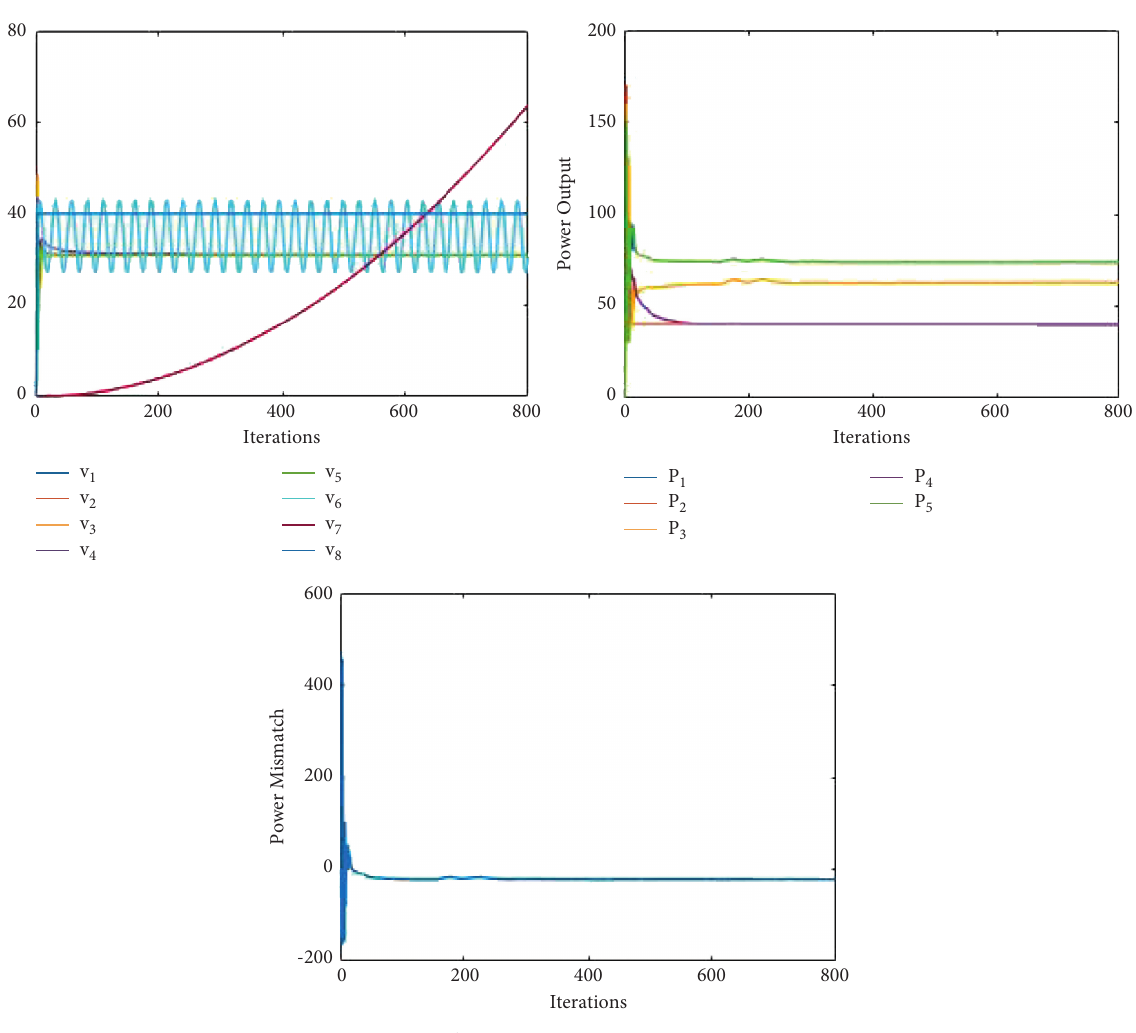
Figure 6: Variables of secure distributed energy management under FDIAs: (a) dual variables, (b) power output, and (c) power